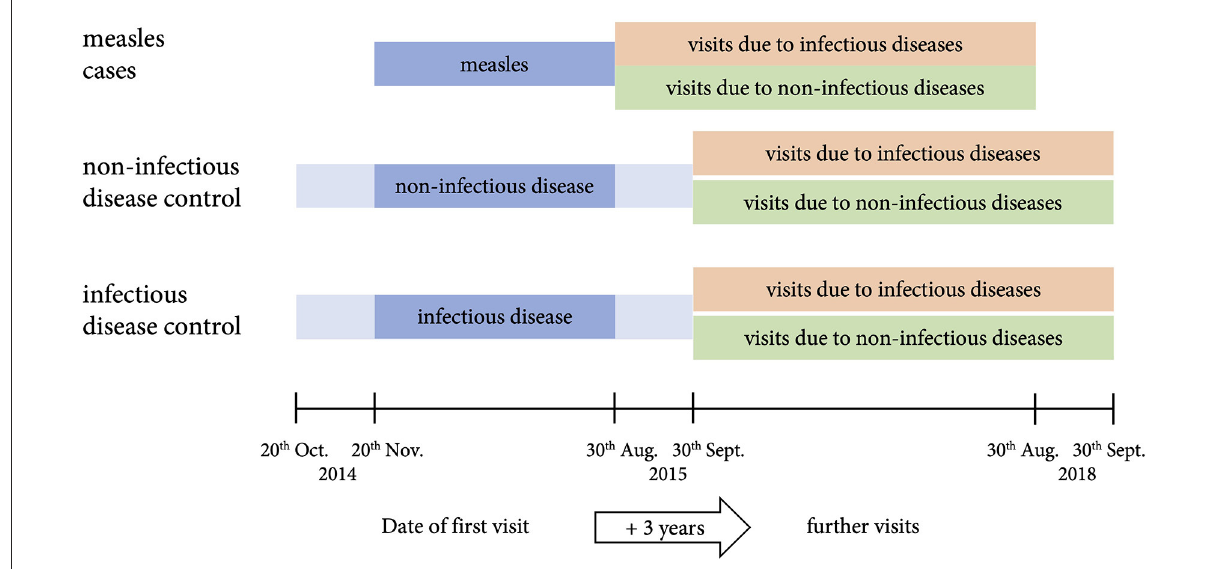
FIGURE1 Study design. Children and adolescents (age ≤ 18 years) who fulfilled the WHO case definition for measles and presented to the emergency room during the measles epidemic between 20th October 2014 and 30th August 2015 were included as cases. Controls were matched for sex, age ( ± 10), date of first visit to the hospital ( ± 1 month, illustrated), and duration of in-patient care if applicable ( ± 20% in full days). All patients were followed up for 3